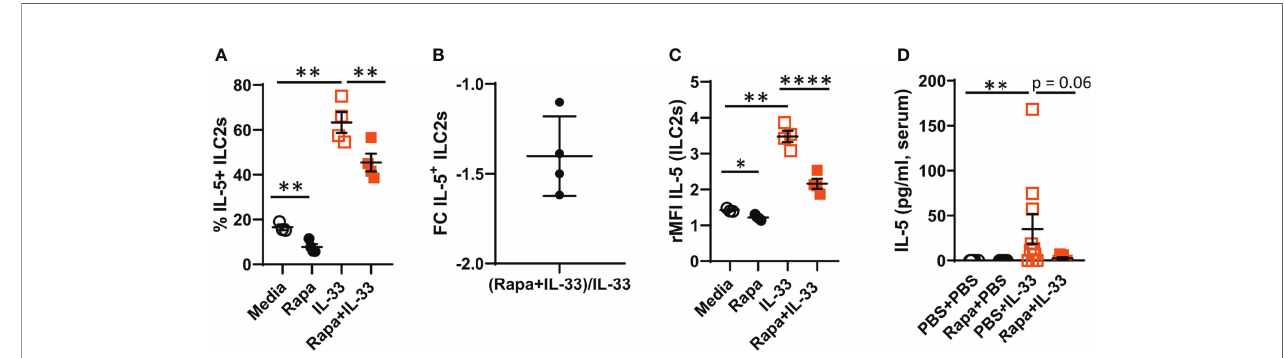
FIGURE 2 | Decreased IL-5 production by bone marrow ILC2s after rapamycin treatment and IL-33 stimulation ex vivo . (A) Number of IL-5 + ILC2 cells. (B) Number of IL-5 + ILC2s in rapamycin+IL-33 and PBS+IL-33 mice shown as fold change (FC). (C) IL-5 intensity in ILC2s measured by relative mean fl uorescence intensity (rMFI). (D) Concentration of IL-5 in serum. Data are representative of 1 – 3 independent experiments (3 – 10/group). Paired Student ’ s t-test (A ,C) , Mann-Whitney U test (D) . *P < 0.05, **P < 0.01 and ****P < 0.0001. Rapa, Rapamycin; i.p, intraperitoneal; i.n., intranasal; PBS+PBS, PBS i.p. and PBS i.n; Rapa+PBS, Rapa i.p. and PBS i.n.; PBS+IL-33, PBS i.p. and IL-33 i.n.; Rapa+IL-33, Rapa i.p. and IL-33 i.n.